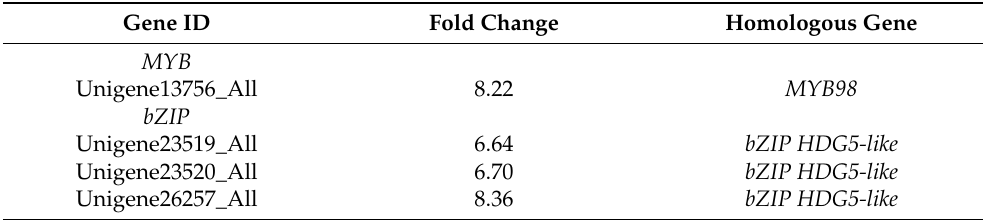
Table 12. The upregulated DEGs related to transcription factors in the roots of A. canescens under 100 mM NaCl, but not under control conditions, for 6